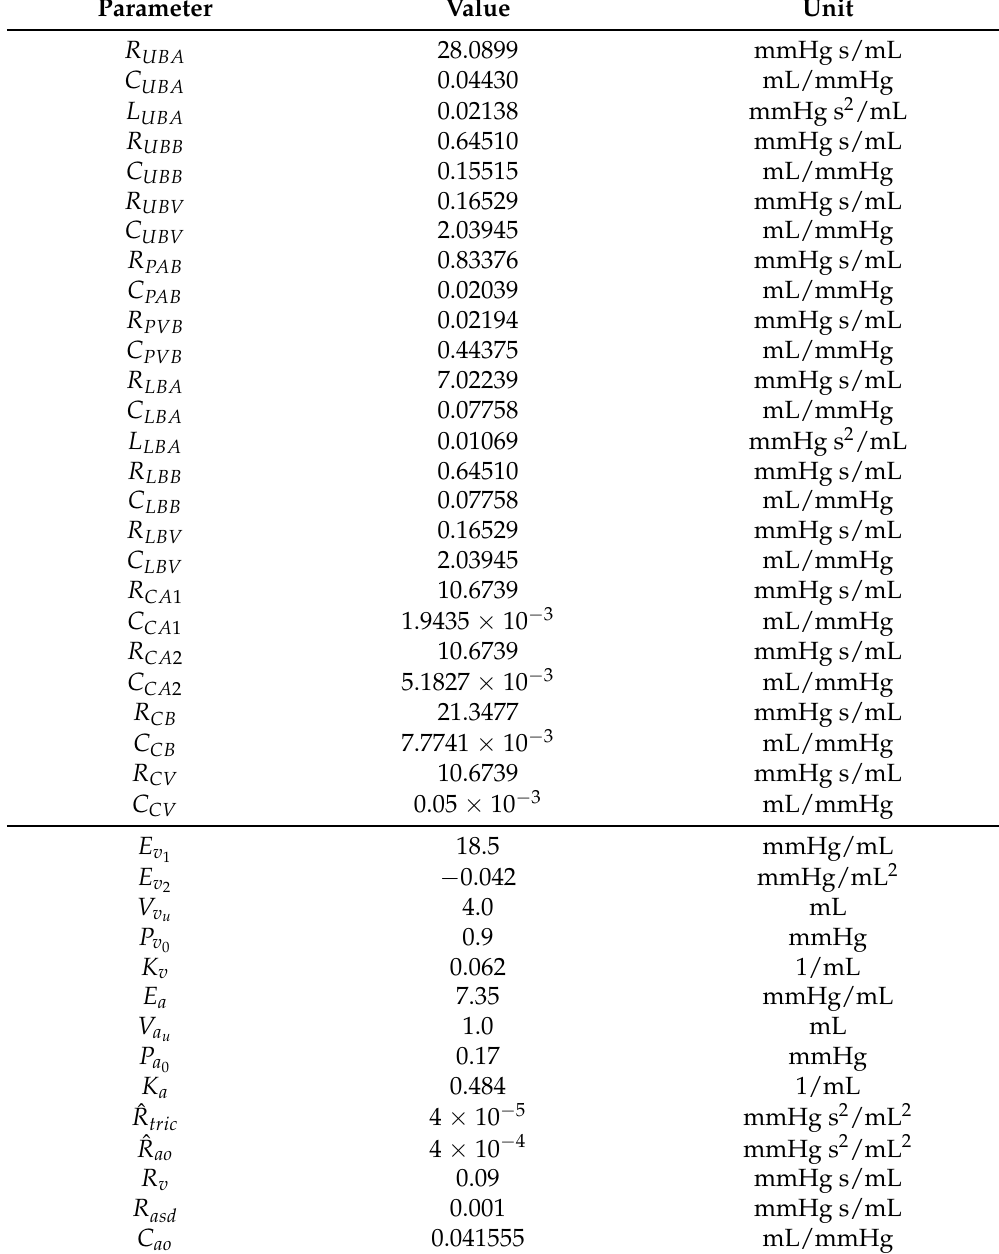
Table A1. Figure 3 parameters values. R , resistance; C , capacitance; L , inductance. The locations of UBA, UBB, UBV, etc.) are marked in Figure 3. E , elastance; P , pressure; K , constant; V , volume; v , single ventricle; u , unstressed; a , atrium; tric , tricuspid; ao , aorta; asd , atrial septal defect. Data from